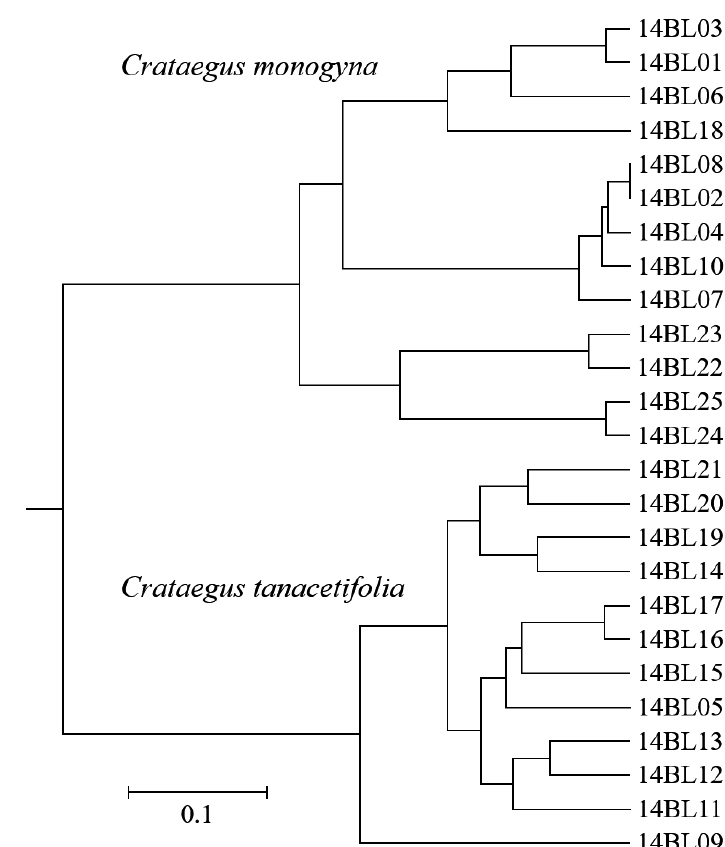
Figure 5. Phylogenetic tree based on Neighbor ‐ joining analyses with iPBS data for genotypes.